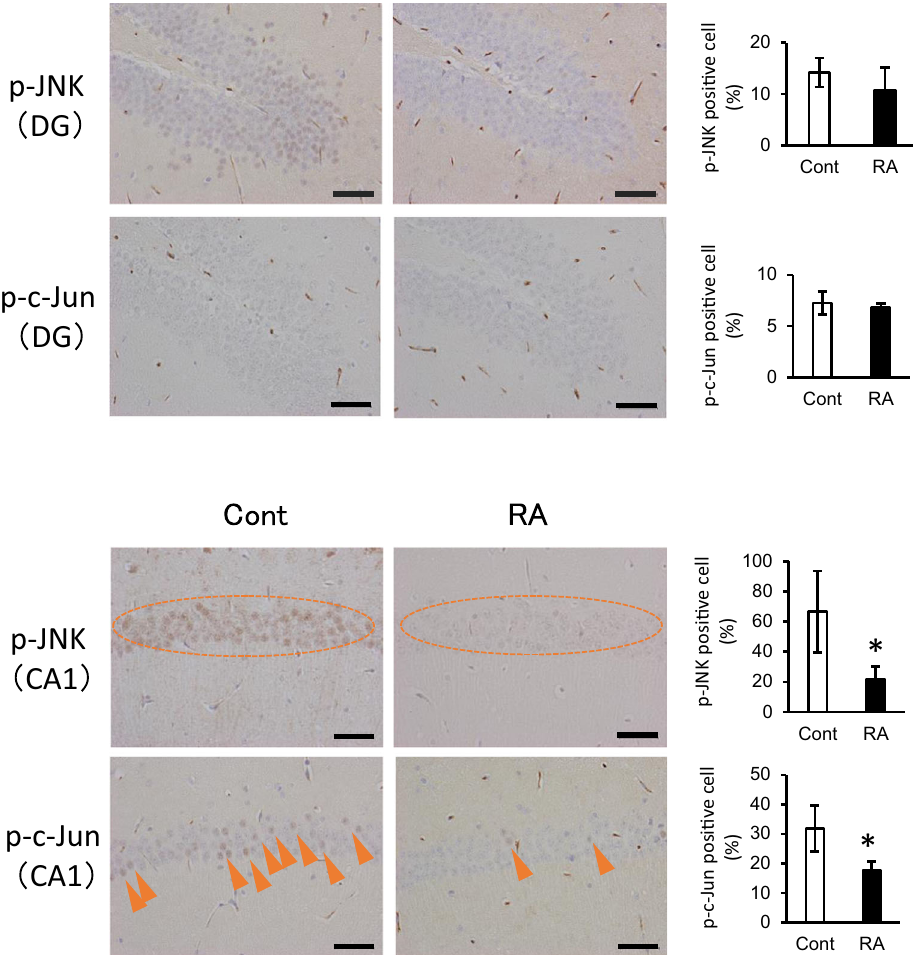
Fig. 6 RA inactivates JNK signaling in the hippocampus. Immunohistochemistry for p-JNK and p-c-Jun in the CA1 region. Active JNK (p-JNK) and p-c-Jun expression levels are decreased by RA supplementation. Paraf fi n sections were stained with anti-p-JNK/p-c-Jun and peroxidase- based labeling (brown), and counterstained with hematoxylin to visualize nuclei (violet). Bregma, − 1.8 to − 2.2 mm; slice thickness, 5 μ m. The CA1 region and dentate gyrus were divided into three areas, and AT8-positive cells were counted to calculate the ratio of cells positive for p-JNK or p-c-Jun to the total number of cells; three mice per group were included in the analyses. The ratio of AT8-positive cells is presented as an average of three areas. Data are shown as means ± standard error. Cont, n = 3; RA, n = 3, * p <